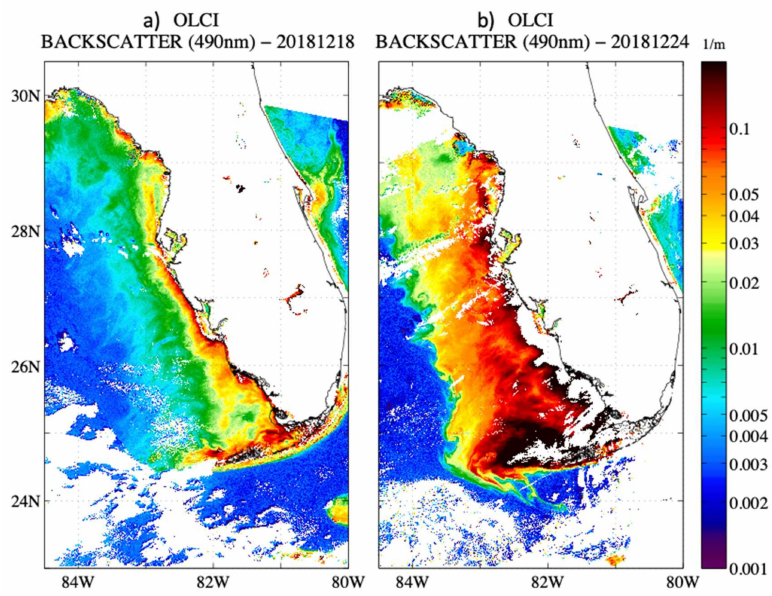
Figure 15. ( a ) QAA backscattering coefficient 490 nm band OLCI, Sentinel 3A, 18 December 2018 and ( b ) QAA backscattering coefficient 490 band OLCI, Sentinel 3B, 24 December 2018. The corresponding QAA total absorption coefficient products do not register nearly as dramatic of a change (Figure 16), although values are elevated on 24 December. The increase is not commensurate with the order-of-magnitude increase in the backscattering signal; thus, the reflectance values are accordingly elevated as well. This result also suggests the backscattering signal is primarily due to non-pigmented particles, that is, inorganic particulates. The likeliest source for such particles over such a vast area of the shelf is the underlying sediments.